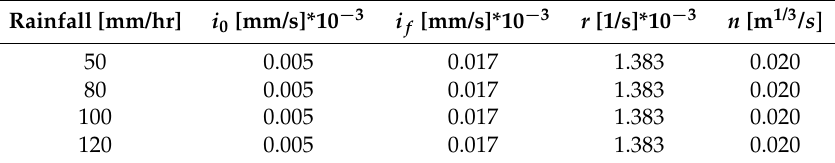
Table 3. Model parameters used for the sensitivity to rainfall intensity scenario.